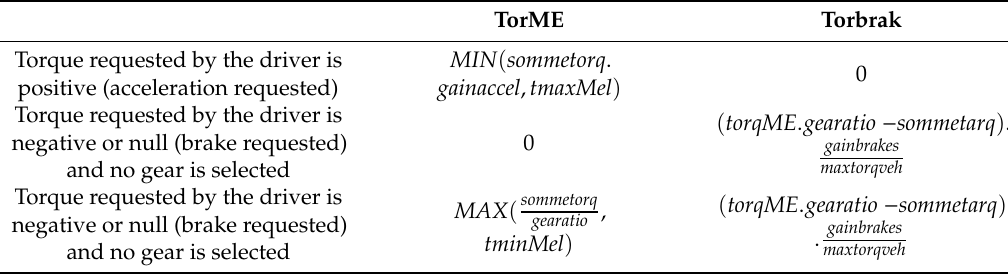
Table 10. Torque required.